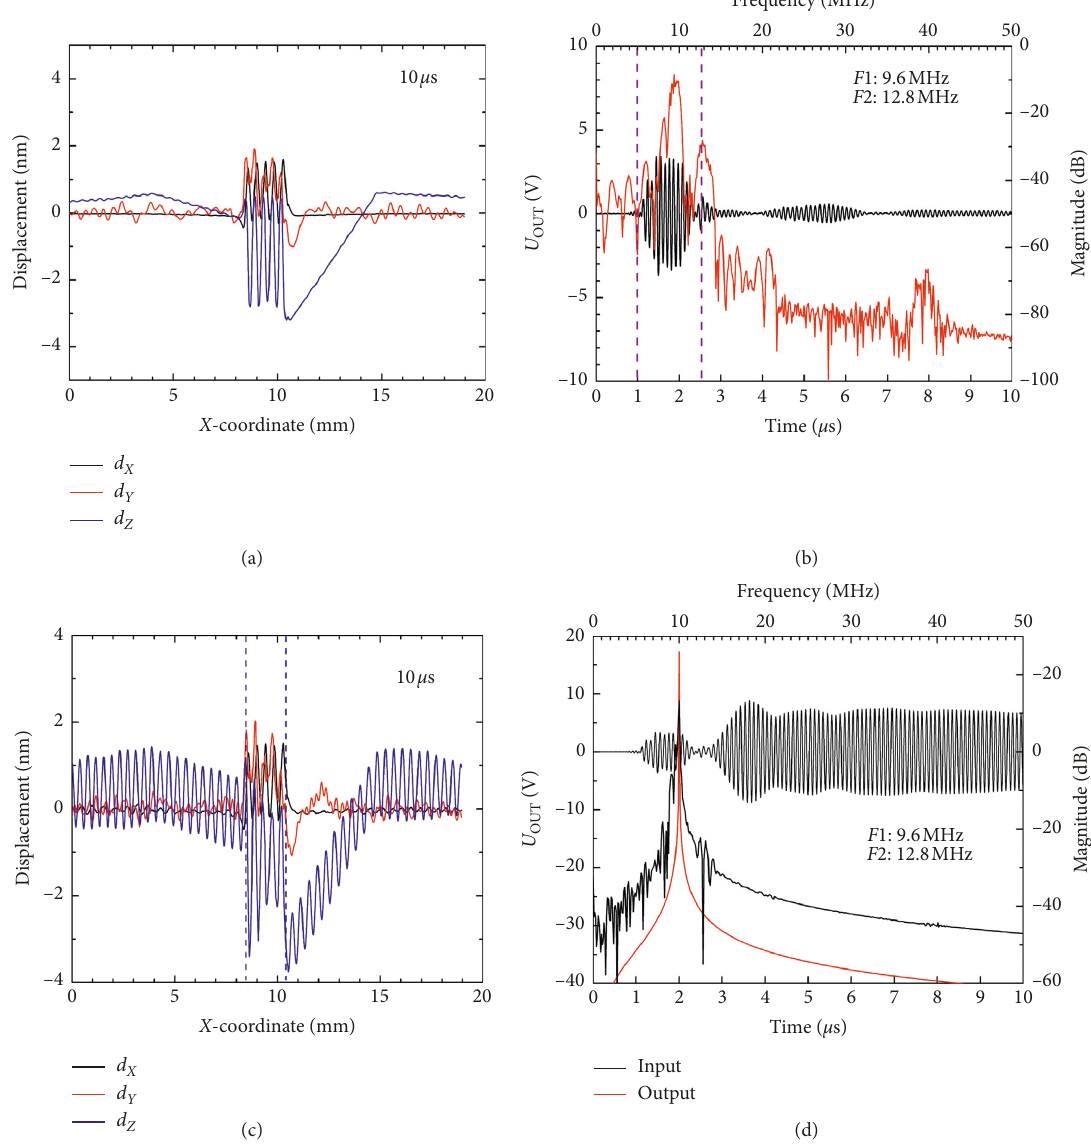
Figure 8: Results of the theoretical investigations of the full 3D FEM model of the SAW device. (a) The d induced static displacement distribution along the wave propagation direction, (b) the registered induced structure formation signal (the black curve) and spectra (the red curve), (c) results of the displacement at the SH-SAW interaction with the induced structure, and (d) the input signal spectra (the red curve) and the output signal and spectra (the black